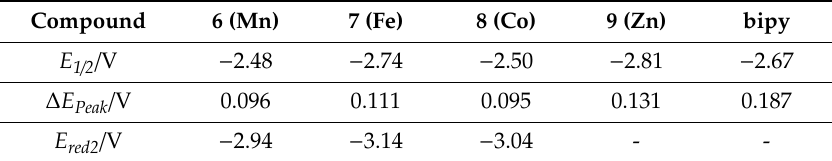
Table 6. Cyclovoltammetric data for compounds 6 – 9 and 2,2 (cid:48)